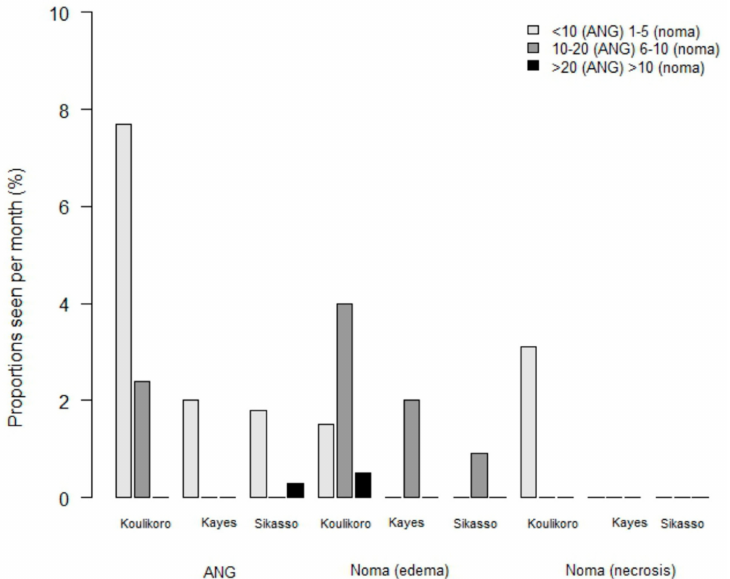
Figure 3. Professional experience of traditional healers in the care of noma cases. The number of monthly reported cases di ff ers for acute necrotizing gingivitis and